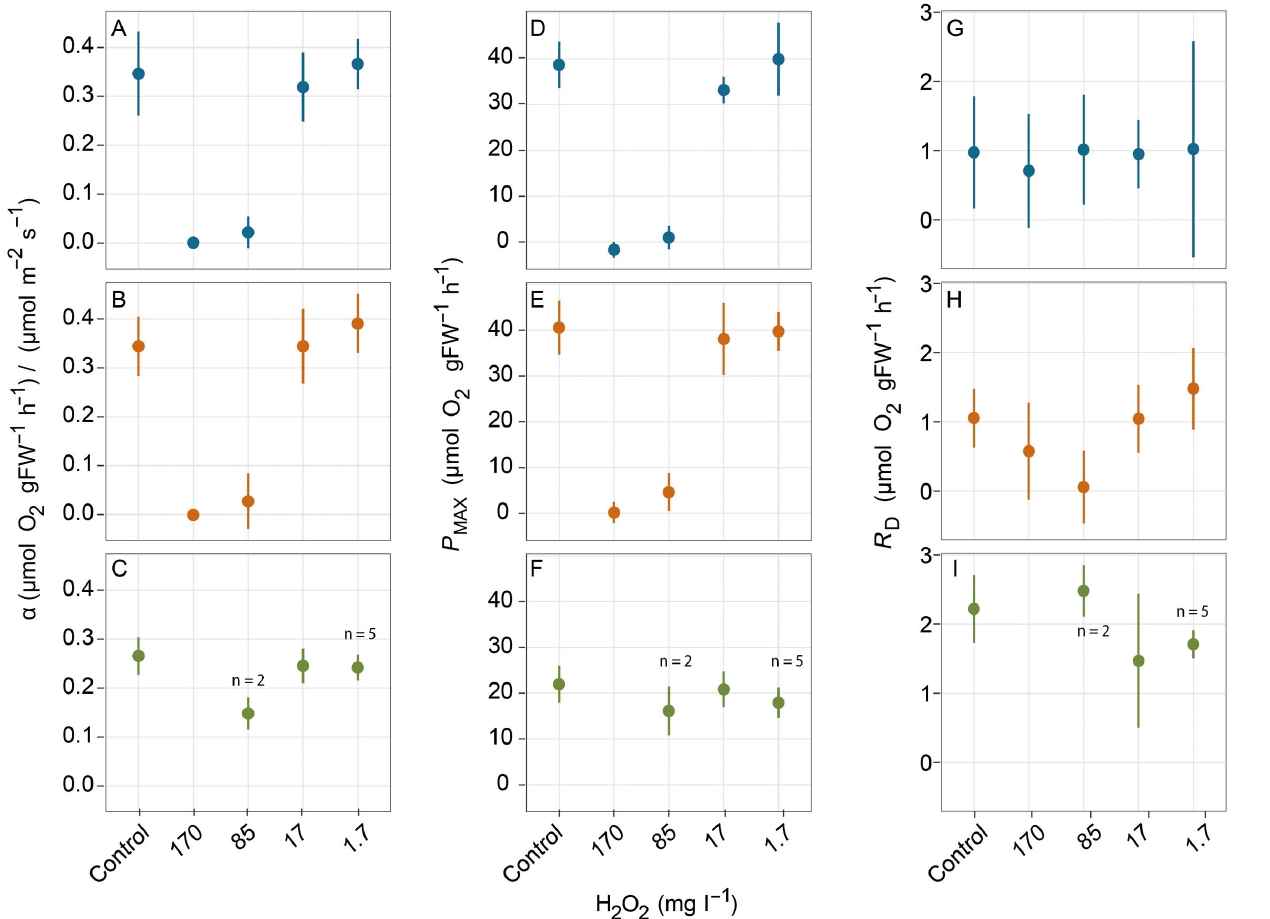
Fig. 4. Effect after 1 h exposure to 5 different concentrations of H 2 O 2 , including control, on photosynthetic parameters (A−C: α : photosynthetic efficiency, D−F: P MAX : maximum photosynthetic rate at high light, G−I: R D : respiration rate in the dark) of juvenile Saccharina latissima plants. Median (±1 SD) response (A,D,G) immediately post-exposure (Day 0), (B,E,H) 24 h post- exposure (Day 1), and (C,F,I) 15 d post-exposure (n = 6 unless otherwise stated). FW: fresh